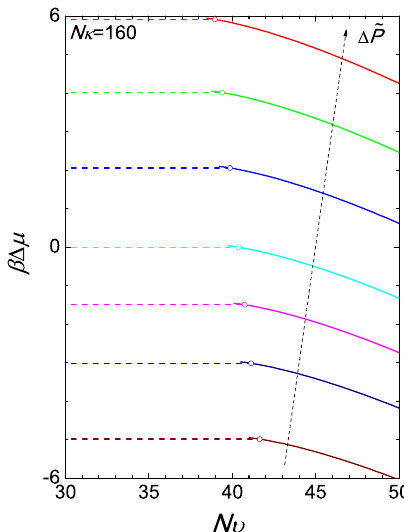
Figure 4. The two branches of the reduced chemical potential difference β ∆ µ . The isotropic-nematic transition can be inferred from the crossing of the isotropic and nematic branches of the Gibbs free energies per chain (equivalent to the chemical potentials plotted here). The colour of a curve corresponds to the pressure difference defined in Figure